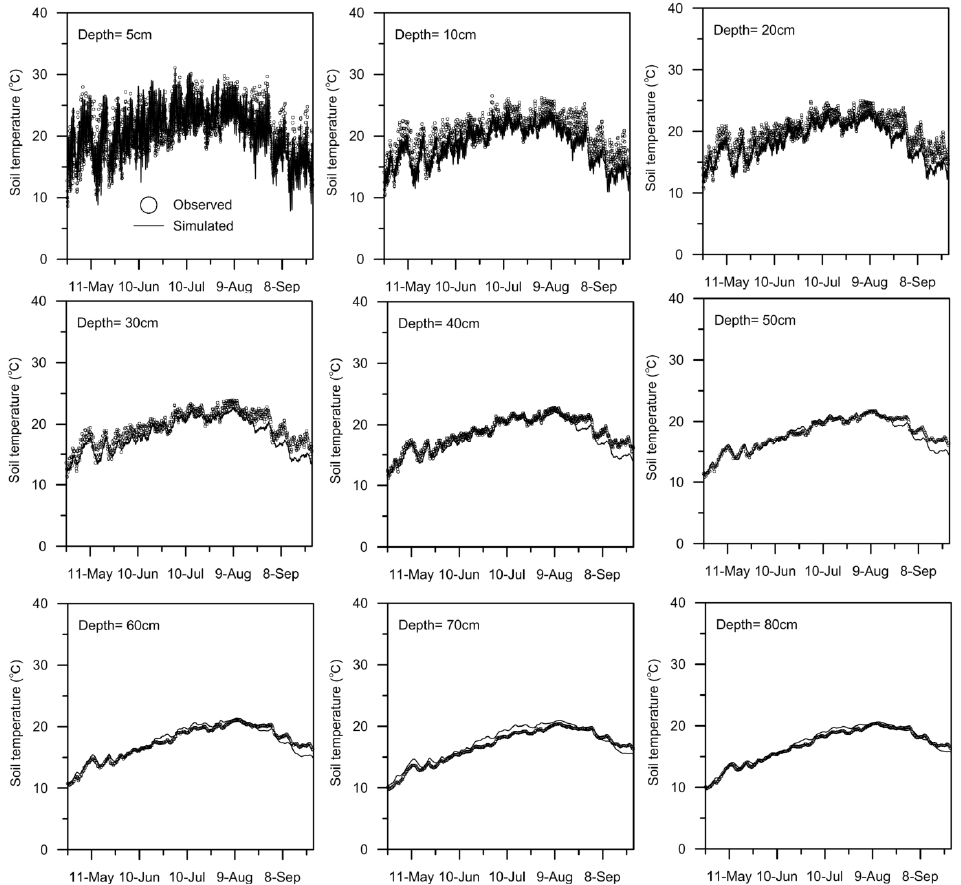
Figure 6. The fit of computed soil temperatures (solid lines) to measured temperatures (points) at nine depths in the soil profile used for calibration (26 April to 12 July) and validation (13 July to 27 September).